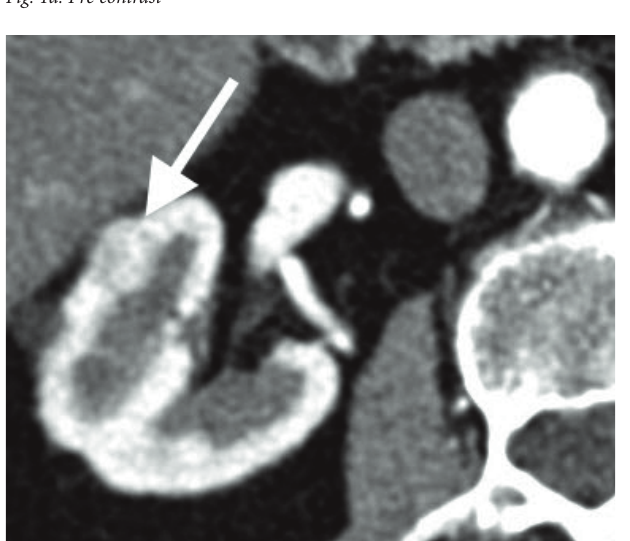
phase.Fig. Fig. 1c. Nephrographic phase.